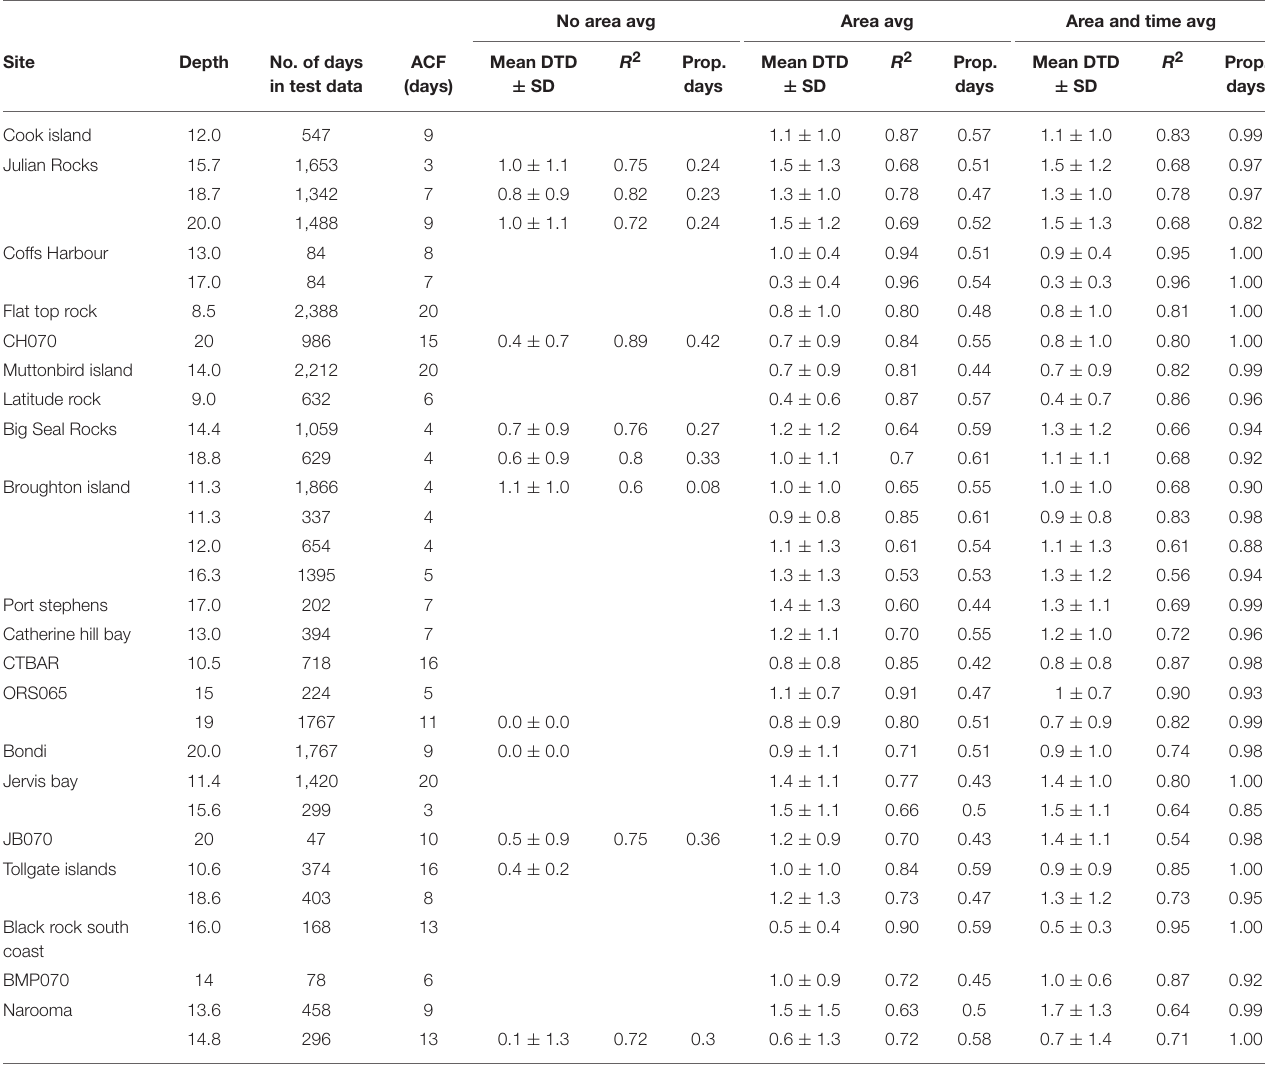
TABLE 2 | Table of data obtained from in situ IMOS moorings and NSW DPI-Fisheries loggers given from north to south with de-correlation times (ACF, days), mean daily temperature difference (daily satellite SST minus in situ temperature- DTD), R 2 values from linear regressions against the in situ data and proportion of study days (prop days) with corresponding satellite